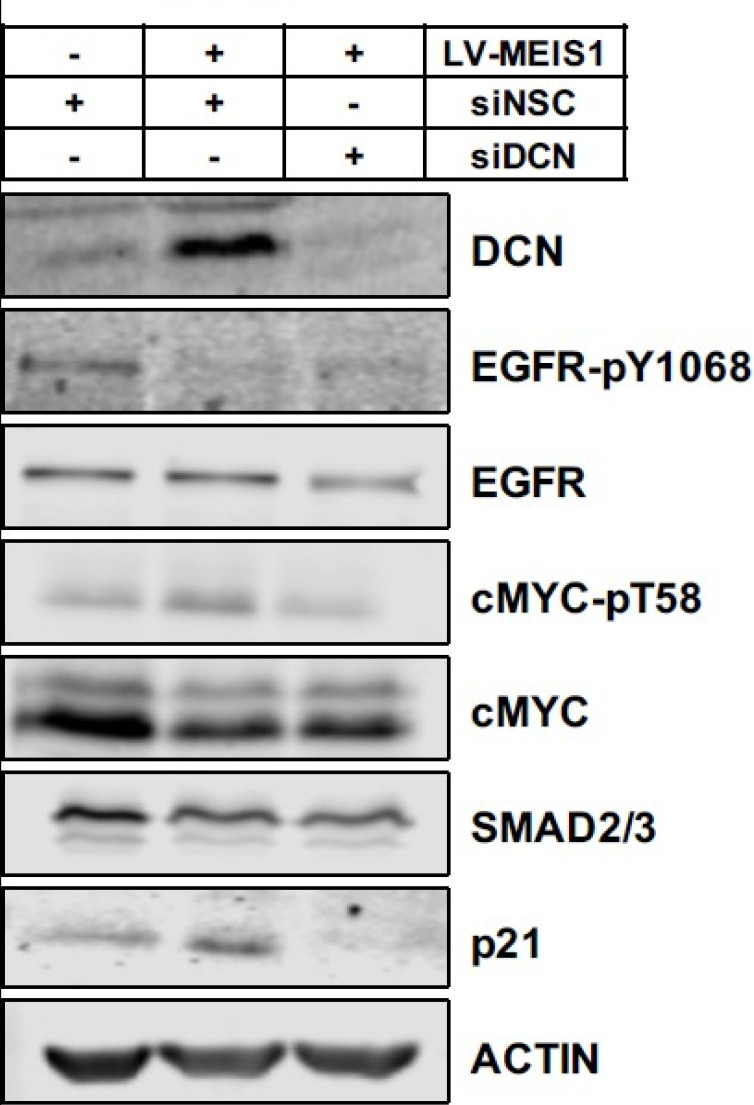
Western blot analysis of MEIS1, HOXB13, DCN, and known downstream targets of DCN in LAPC4 control-siNSC, LV-MEIS1-siNSC, and LV-MEIS1-siDCN cells.